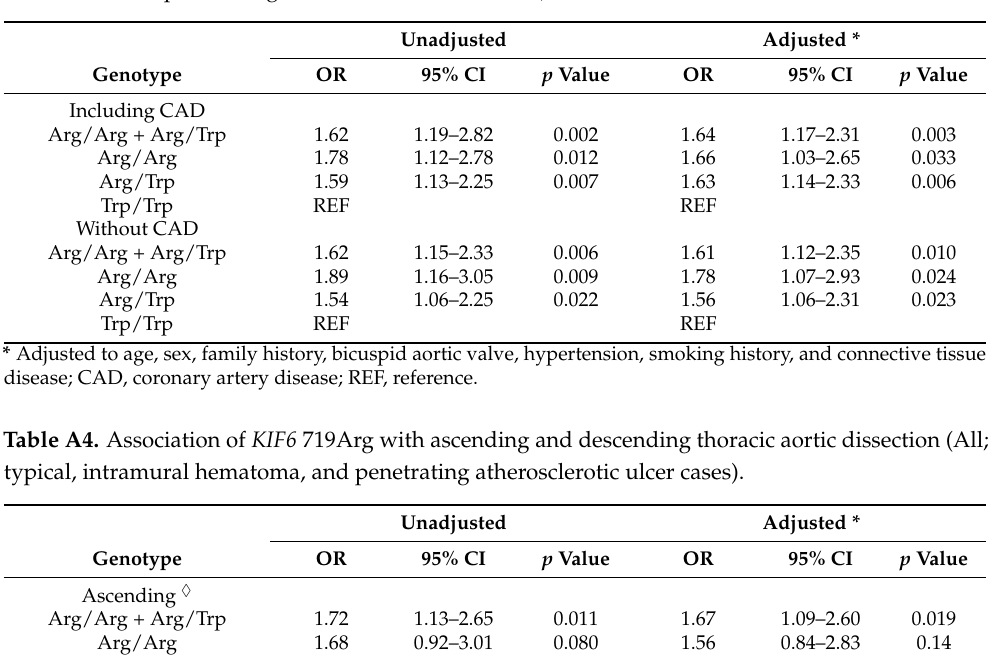
Table A3. Association of KIF6 719Arg with thoracic aortic dissection (all; typical, intramural hematoma, and penetrating atherosclerotic ulcer cases).